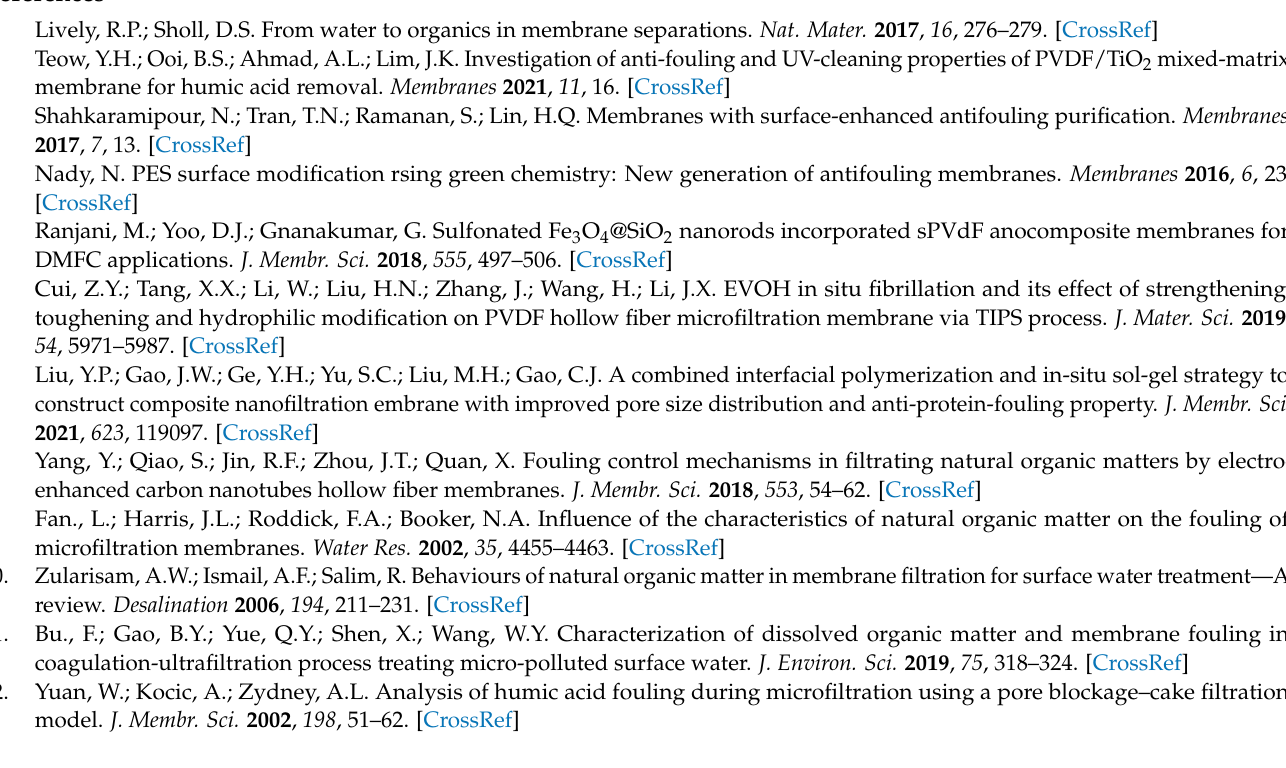
membranes., Figure S2: AFM photographs of the modified membranes with a monomer, Figure S3: Porosity and mean pore size of the membranes, Figure S4: Particle size distribution of foulants. Figure S5: SEM images ( × 7000) of the M2-2 modified membrane before and after ultrasonic treatment, soaking in acid (pH = 2) or alkaline (pH = 9) aqueous solution, Figure S6: The flux of the membranes before and after ultrasonic treatment or soaking (pH = 2, 9). Table S1: Weight ratio of monomer solutions for the PVDF modified membranes, Table S2: Membrane weight before and after ultrasonic and immersion treatment (pH = 2, 9) for 30 min,